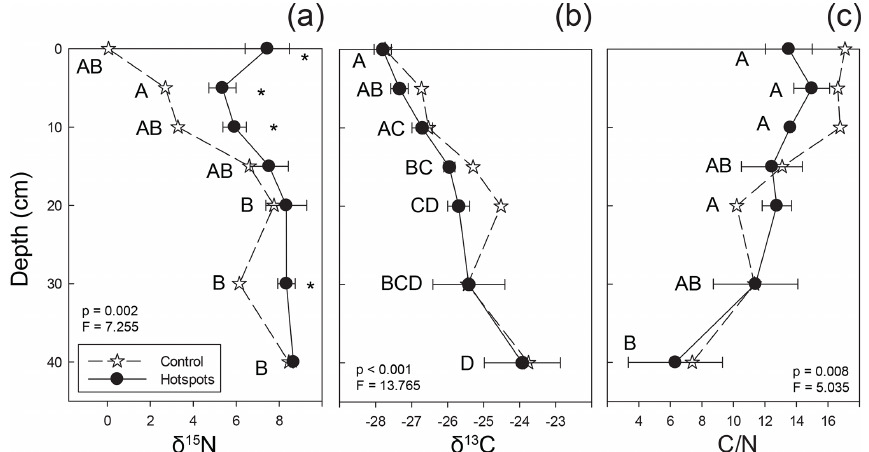
Figure 5. Stable isotopic composition and C / N ratios for soils beneath carrion hotspots (closed circles) and at a control location (stars). Letters indicate hotspot soil samples as a function of depth that were not significantly different based on post hoc testing, and asterisks indicate significant differences between control and hotspot soils at each depth interval (both based on one-way ANOVA, p < 0 . 05).